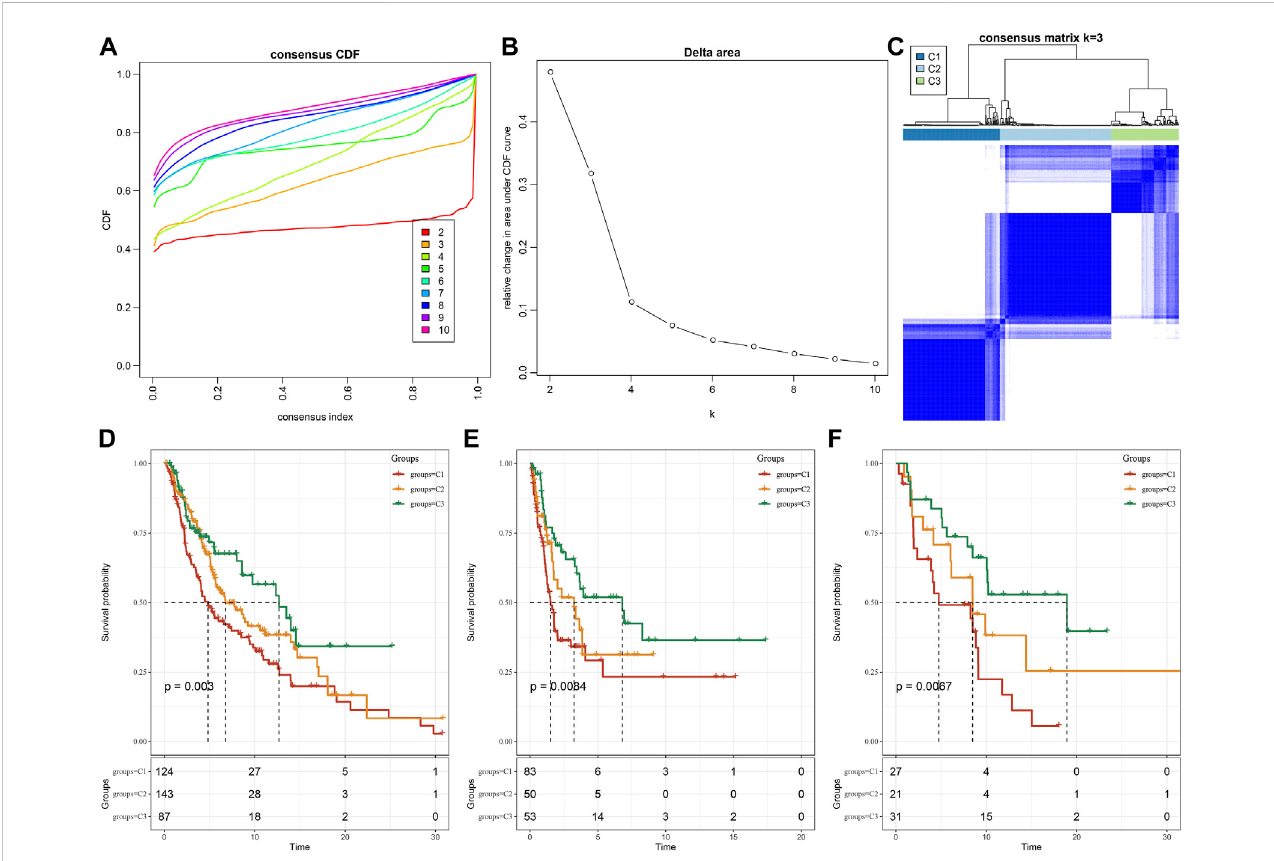
FIGURE 2 Molecular subtypesbasedonLRpairs. (A) TCGAcohortsampleCDFcurve. (B) TCGAcohortsampleCDFDeltaareacurve.Deltaareacurveofconsensus clustering, indicating the relative change in area under the cumulative distribution function (CDF) curve for each category number k compared with k – 1. The horizontal axis represents the category number k and the vertical axis represents the relative change in area under the CDF curve. (C) Clustering heat map of TCGA samples when consensus k = 3. (D) OS time prognosis survival curves of molecular subtypes of TCGA. (E) OS time prognosis survival curves of molecular subtypes of GSE65094. (F) Three types of subtypes in GSE54467 Prognostic OS time prognostic survival